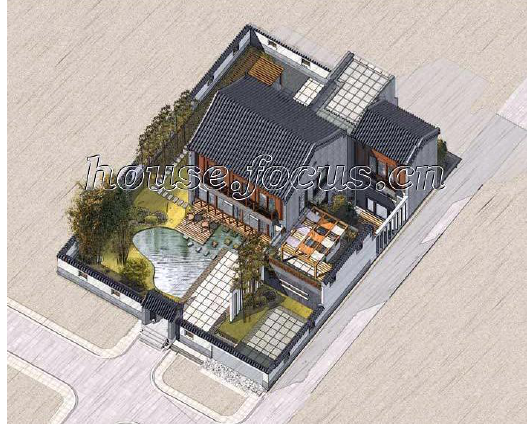
Figure 8. Computer-rendered axon of a Beijing Guantang courtyard garden villa. Source: house.focus.cn,